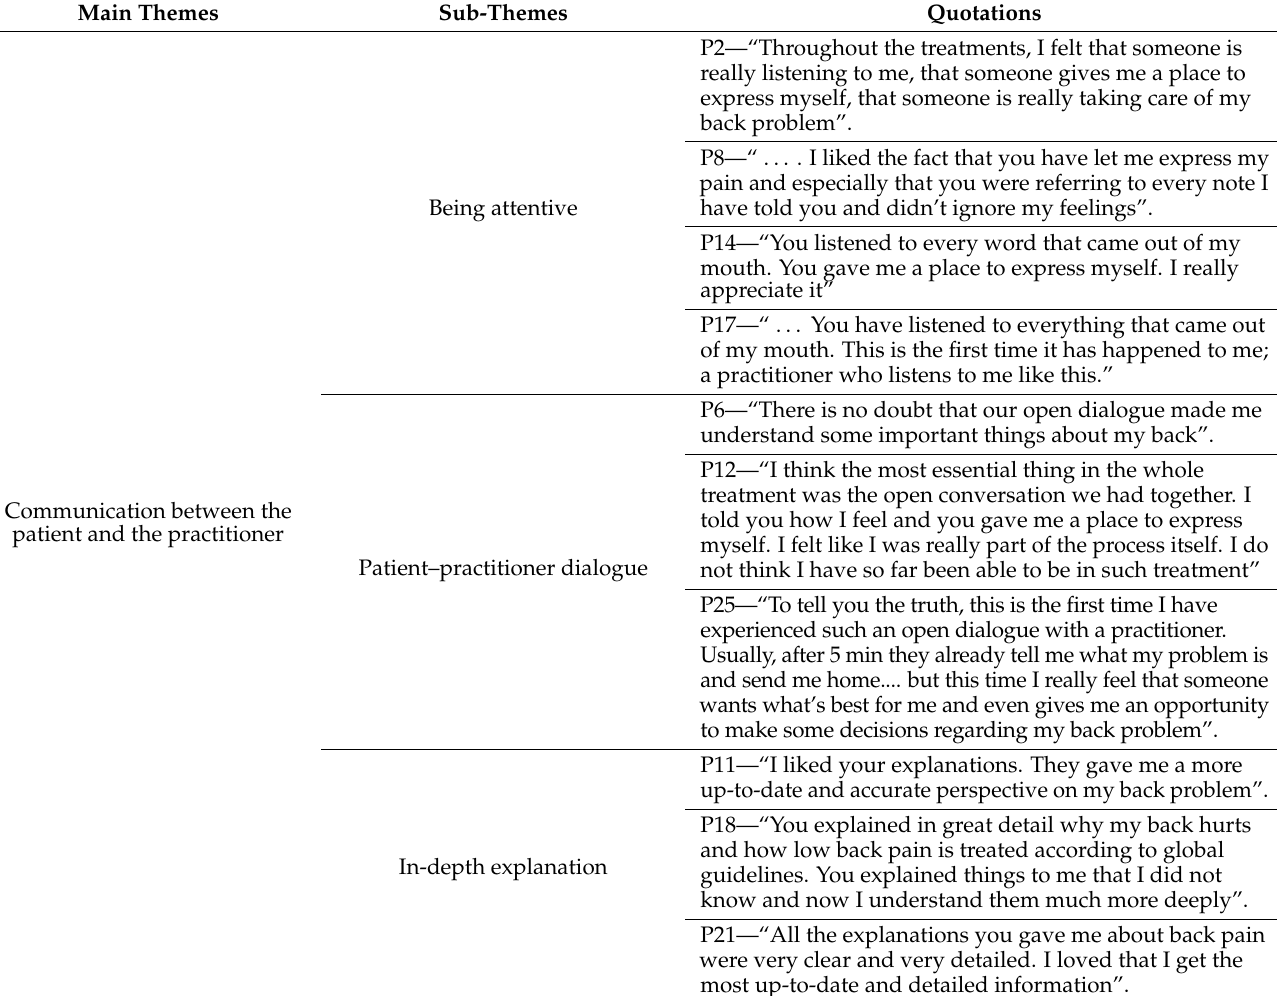
Table 5. Theme and sub-theme